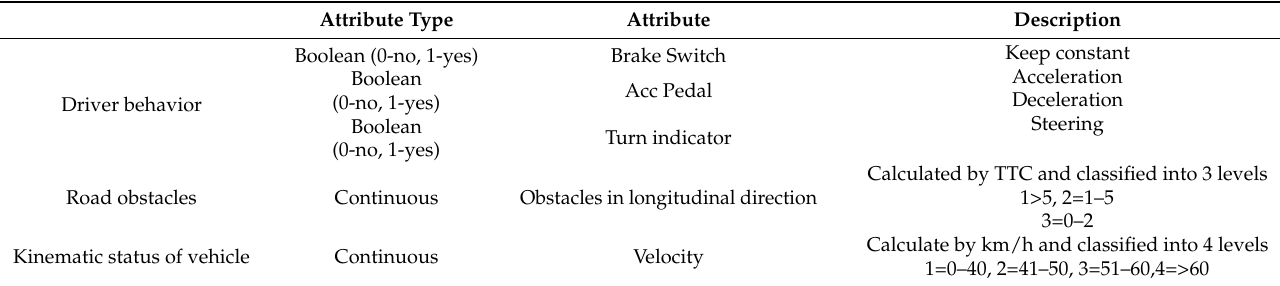
Table 3. Attributes of driver behavior